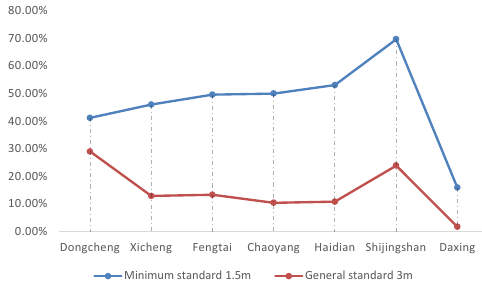
Figure 7. Sidewalk width evaluation results of the partition